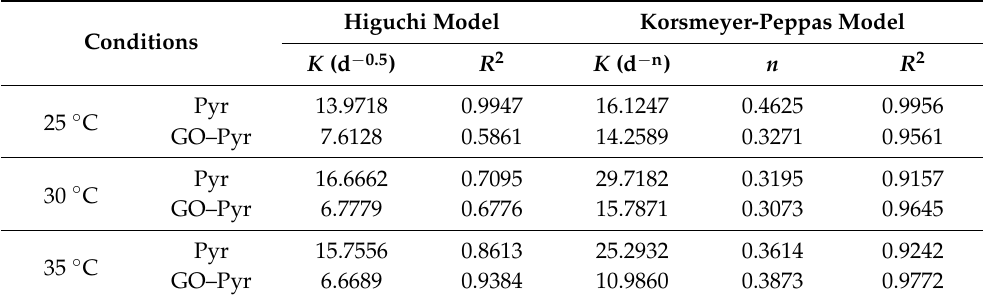
Table 1. Kinetic parameters of Pyr release from GO–Pyr nanocomposite at 25 ◦ C, 30 ◦ C and 35 ◦ C. Conditions